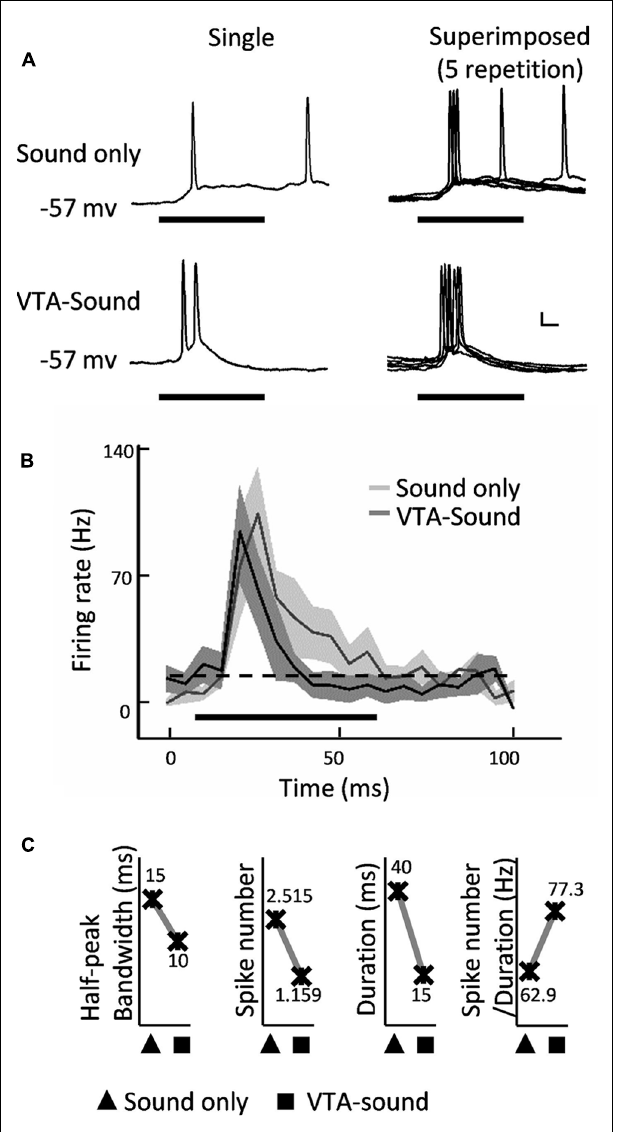
FIGURE 2 | Spiking response ofA1 neurons was compressed by paired VTA-sound stimulation. (A) Example of an intracellular recording from a neuron in rat A1: top, sound only group; bottom, pairedVTA-sound group; left, single trace of response; right, five superimposed traces.Thick black bar indicates the sound stimulation. Scale bar: 10 mV/10ms. (B) Averaged firing rate (mean ± S.D.) of neuronal responses evoked by two stimulation groups ( n = 13). Shading indicates the SD. Sound only group: light gray; pairedVTA-sound group: dark gray. 5 ms binning window. Dashed line showed the baseline of spontaneous firing.Thick black bar indicates the sound stimulation. (C) WhenVTA-sound stimuli were paired the half-peak bandwidth, spike number and duration of sound evoked spiking responses decreased except that the ratio between spike number and duration